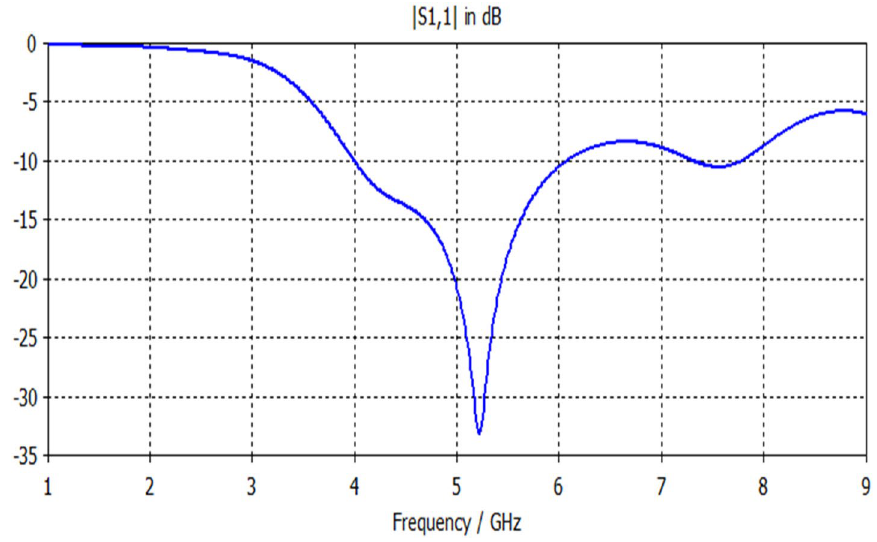
Figure 7. S11 response of Antenna3.